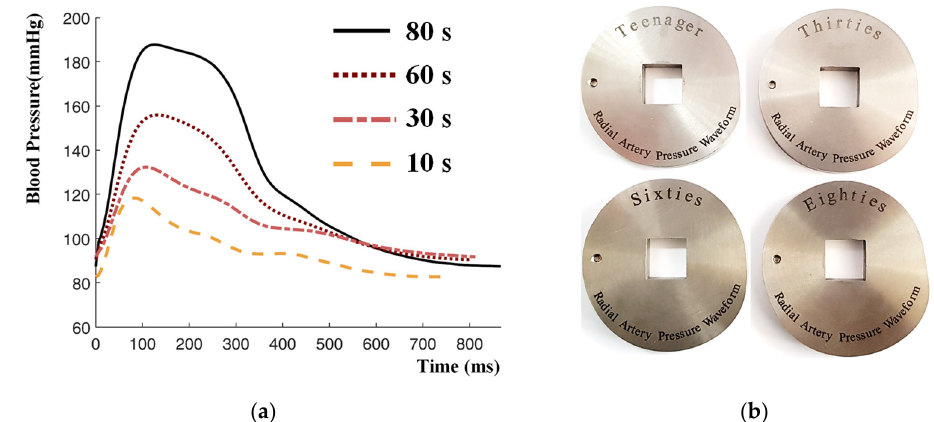
Figure 8. Experimental setup using age-dependent cams; ( a ) tonometric measurement results of radial artery pressure waveforms of subjects by age, ( b ) fabricated age-dependent cams.